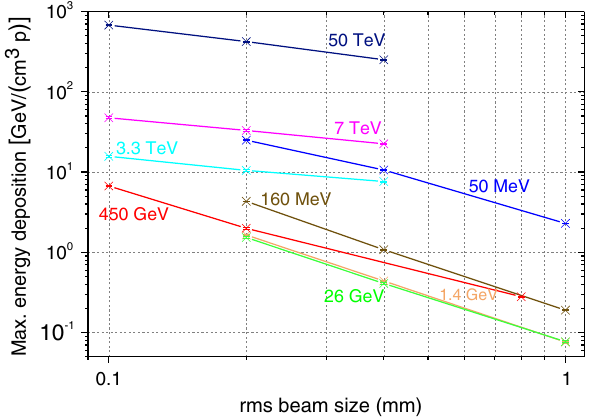
FIG. 18. Energy deposition or loss rate per proton in a thin graphite target as a function of kinetic energy ranging from 50 MeV to 50 TeV. Comparisons are made between FLUKA simulations (energy deposition per target length) and direct calculations using the Bethe equation (energy loss rate). For the simulation results, three target thicknesses are considered as denoted in the figure.